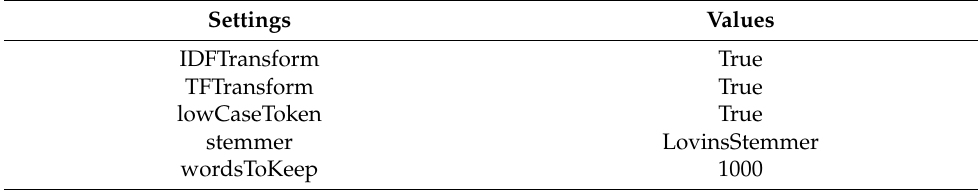
Table 8. The settings of filters in the ensemble learning using Bagging method.